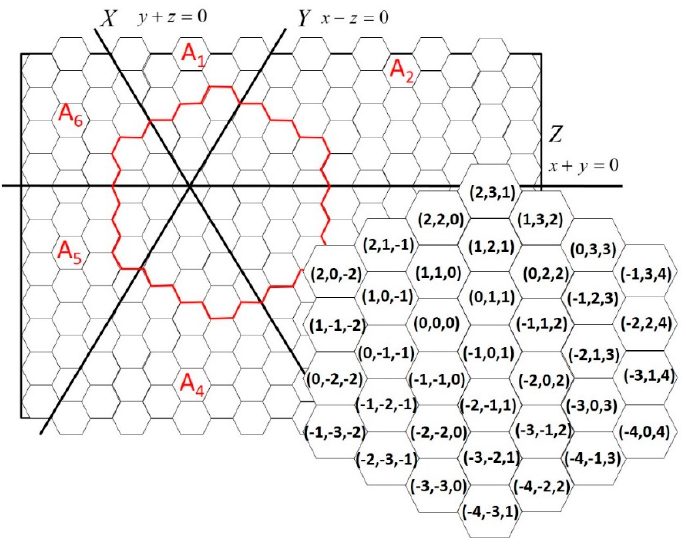
Figure 3. Coordinates of cells in the charging zone.